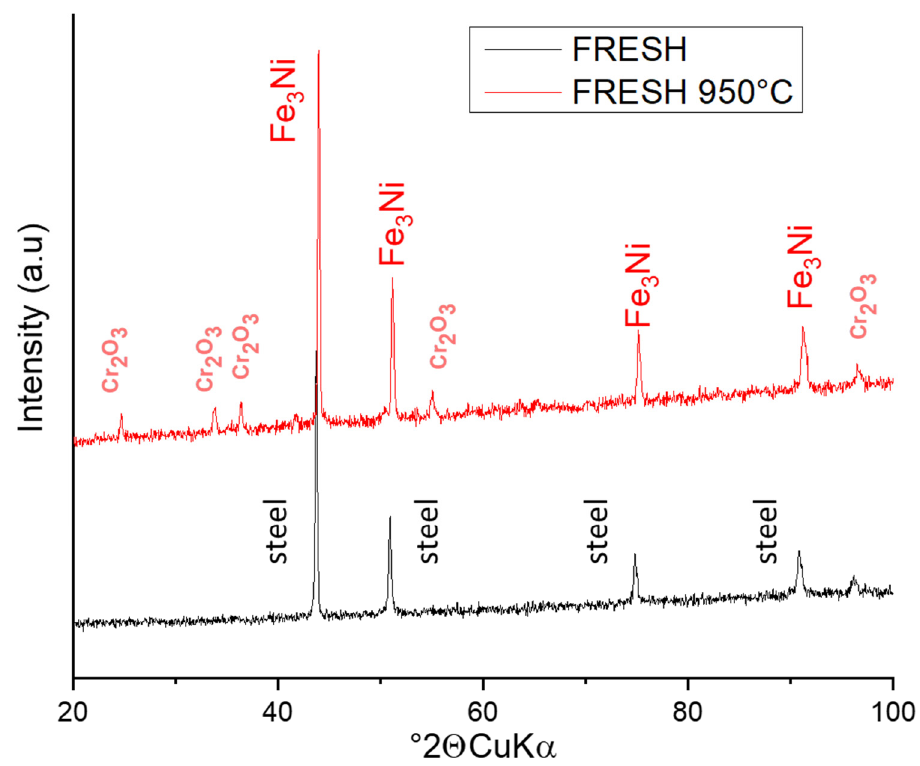
Figure 7. XRD pattern of FRESH sample before and after treatment 950 °C. The most intensive peaks are noted with analyzed phase name.